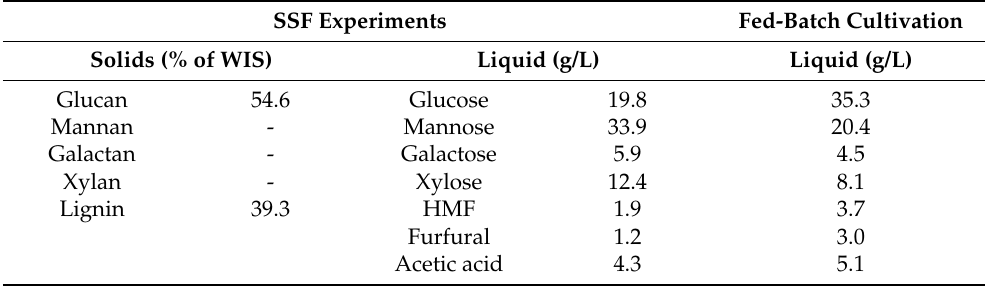
Table 1. Composition of the pre-treated spruce materials. The water-insoluble solids (WIS) content of the material was 15.0%. Note that the phenolic compounds could not be quantitatively analyzed by the HPLC method used for analyses of the